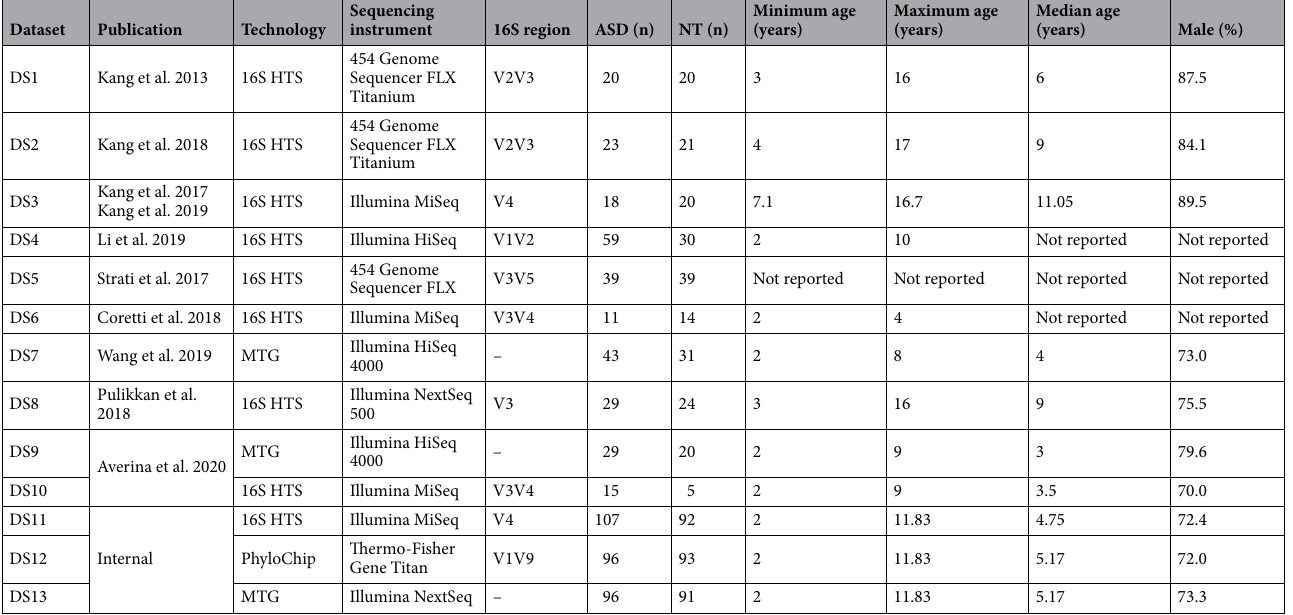
Table 1. Summary of datasets. HTS high-throughput sequencing, MTG metagenomics.